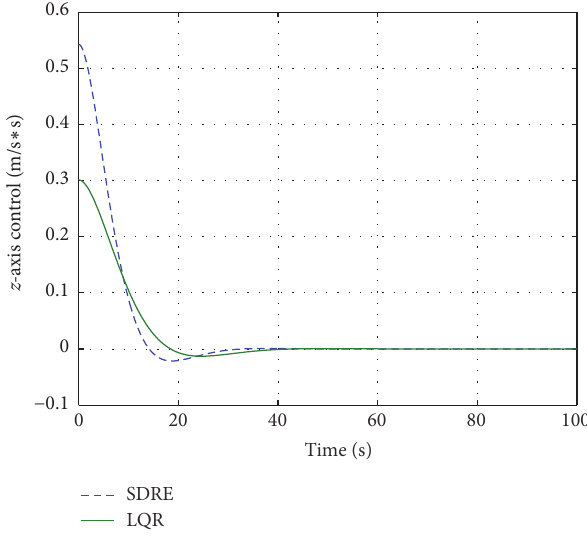
Figure 14: 𝑍 axis control change